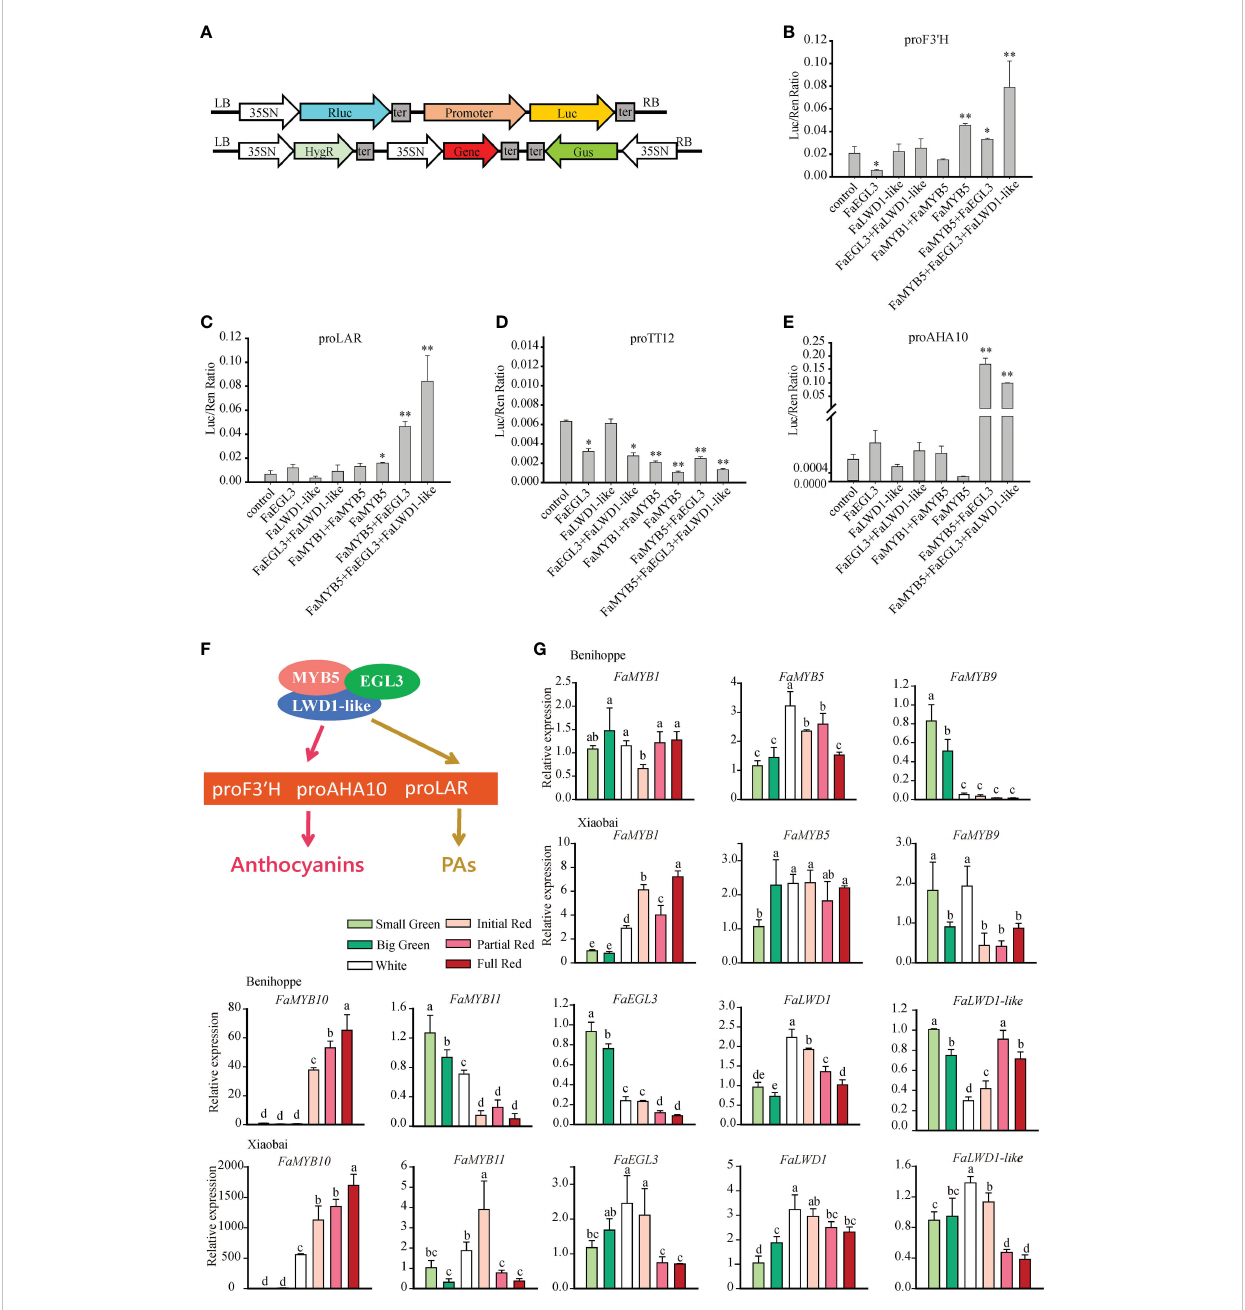
FIGURE 5 The effect of FaMYB5 and its involved MBW complex on target genes. (A) Schematic diagram of Dual-luciferase transient expression vectors. Promoters were combined into pGreenII0800-LUC vector as reporters, genes fused into pCAMBIA1301-d35SN were used as effectors and the empty pCAMBIA1301-d35SN was as a negative control. (B-E) Validation of the activation effect by FaMYB1, FaMYB5, FaEGL3, and FaLWD1-like on four promoters using dual luciferase assay in tobacco leaves. Error bars are SEs for three replicates, statistical signi fi cance was determined by Student ’ s t-test (**, P < 0.01; *, P < 0.05). (F) The regulation complex model on anthocyanins and PAs in strawberry fruit. FaMYB5/FaEGL3/FaLWD1- like MBW ternary complex regulates anthocyanins and PAs by directly binding to the promoters of F3 ′ H, AHA10 and LAR. (G) Expression Patterns